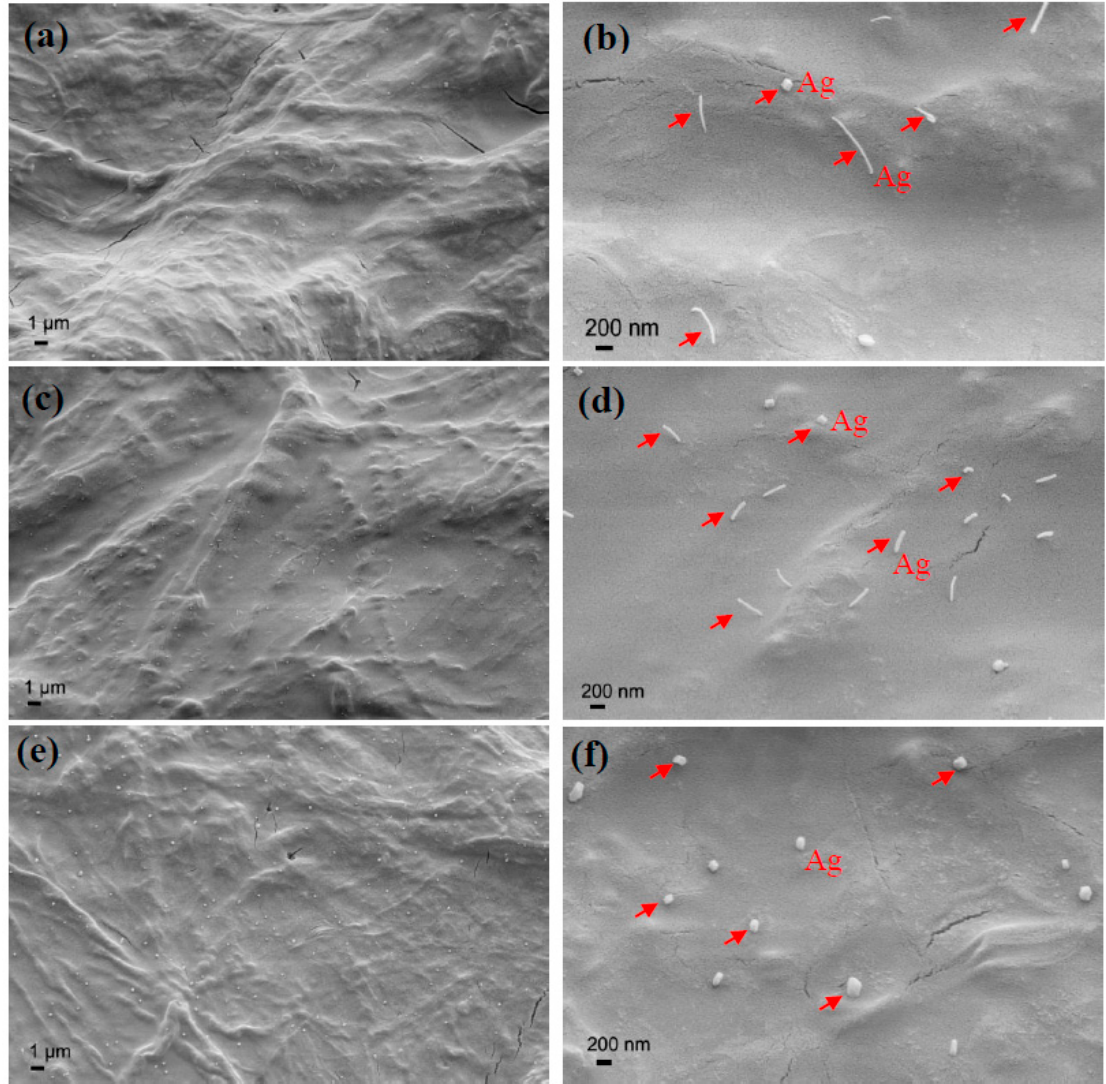
Figure 4. SEM images of Ag/TiO 2 /cellulose composite films with different loadings of Ag at lower and higher magnification: ( a,b ) 0.2 mol % ratio of Ag to TiO 2 ; ( c,d ) 1.0 mol % ratio of Ag to TiO 2 ; and ( e,f ) 5.0 mol % ratio of Ag to TiO 2 . Polymers 2018 , 10 , x FOR PEER REVIEW